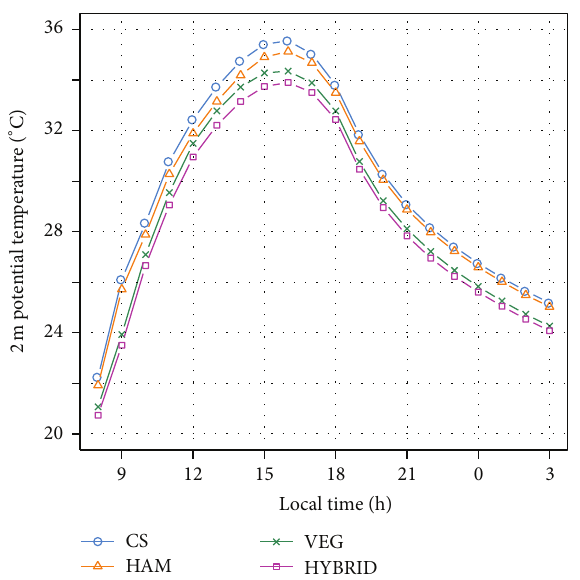
Figure 13: 2 m potential temperature time series simulated by ENVI-met from 08:00 July 18th 2009 till 03:00 19th 2009 for the current situation, as well as under consideration of three mentioned UHI mitigation strategies.